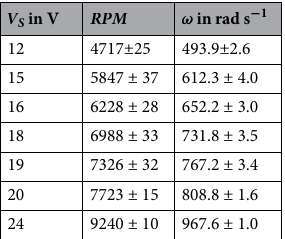
Table 2. Measured rotational speeds of the lathe in no load condition.